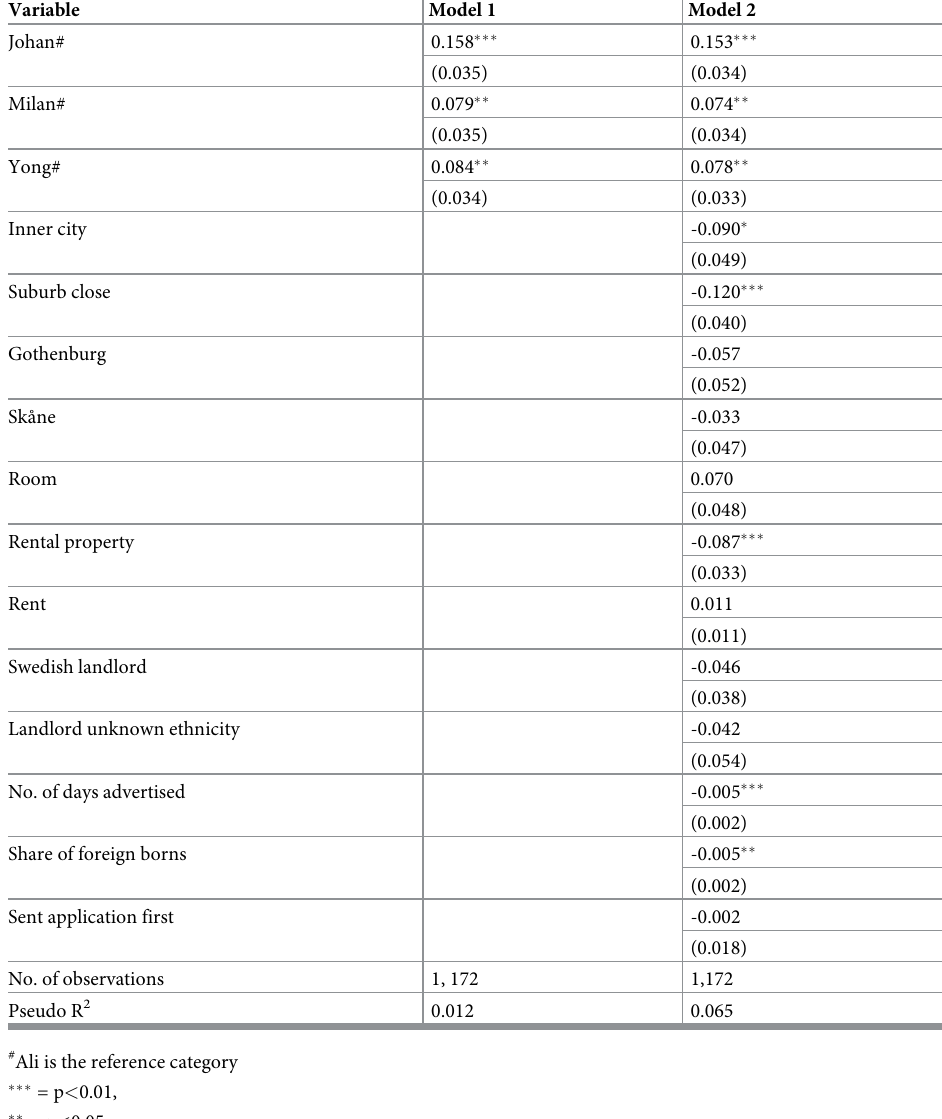
Table 3. Robust marginal effects from a binary probit regression. The dependent variable is callback . Standard deviations in parentheses and they are clustered at advertisement level.